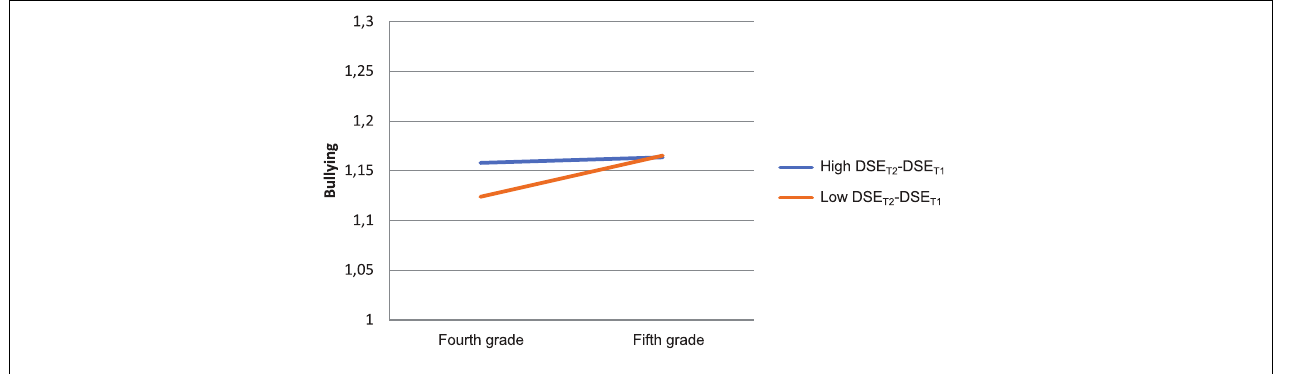
FIGURE 2 | Interaction effect on bullying change: Defender self-efficacy (DSE) change × grade.